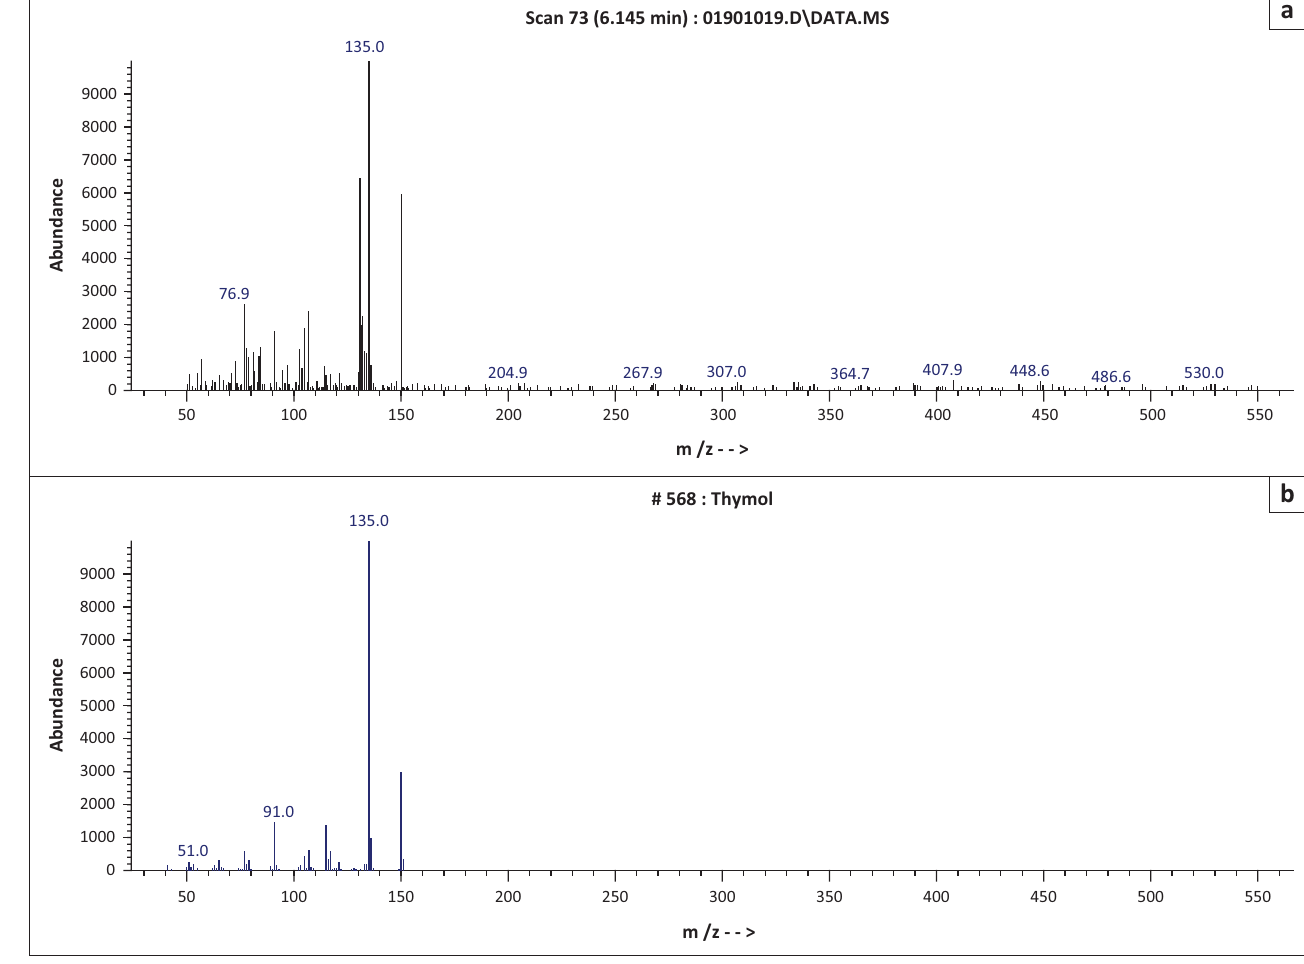
FIGURE 4: Gas chromatography – mass spectrometer spectra of